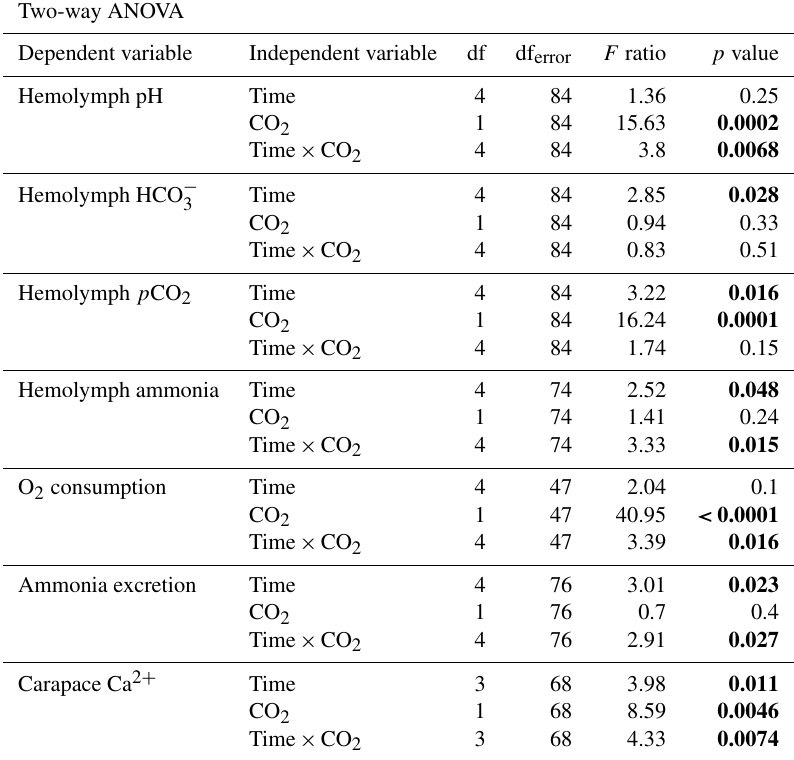
Table 2. Statistical results of two-way ANOVAs from hemolymph acid–base parameters, oxygen consumption, ammonia excretion, and carapace calcification experiments. For hemolymph acid–base measurements response variables were hemolymph pH, HCO − ammonia with time and CO 2 as a fixed independent variable. For whole-animal experiments, response variables were oxygen consumption rate and ammonia excretion rate with time and CO 2 as a fixed independent variable. For carapace calcification experiments, the response variable was carapace calcium content with time and CO 2 as a fixed independent variable. p values below 0.05 are considered statistically significant and are bolded. df denotes degrees of